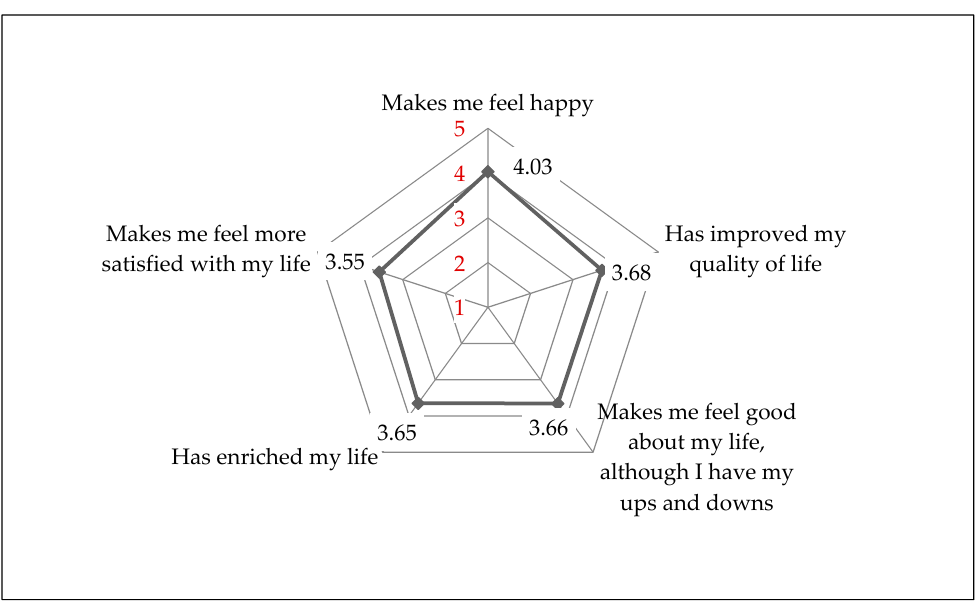
Graph 5. Assessment of the variable Quality of Life.